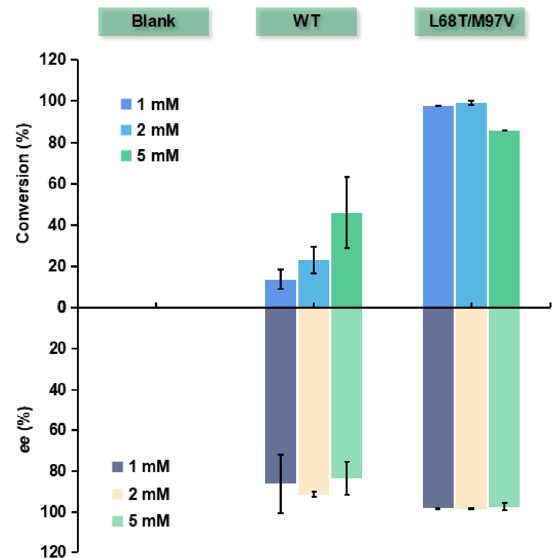
Fig. 7 Asymmetric synthesis of bulky THIQAs using 4‑bipenzaldehyde and dopamine as substrates. The reaction mixture was composed of 2 eq. amine, 1 eq. aldehyde, 20% (v/v) DMSO, 5 mM ascorbic acid, HEPES buffer (100 mM, pH 7.5) and 4 mg mL − 1 purified enzyme. Reactions were performed at 40 °C for 24 h